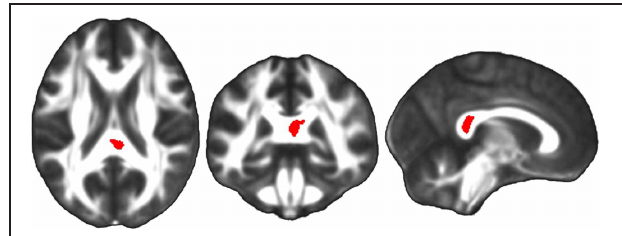
FIGURE 7 | Linear regression analyses, in which neuropsychological test scores were the independent variables and FA maps were the dependent variables, demonstrated a significant correlation between performance on a finger tapping task and FA in the splenium of the corpus callosum among TBI patients at the second time point (red). The left side of the statistical map is patient left and right is patient right.